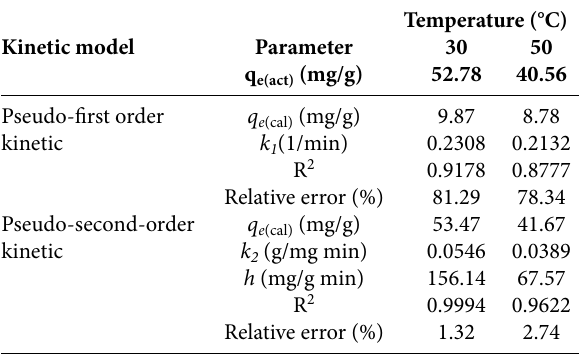
Table 5. Kinetic parameters of CO 2 adsorption onto CeO 2